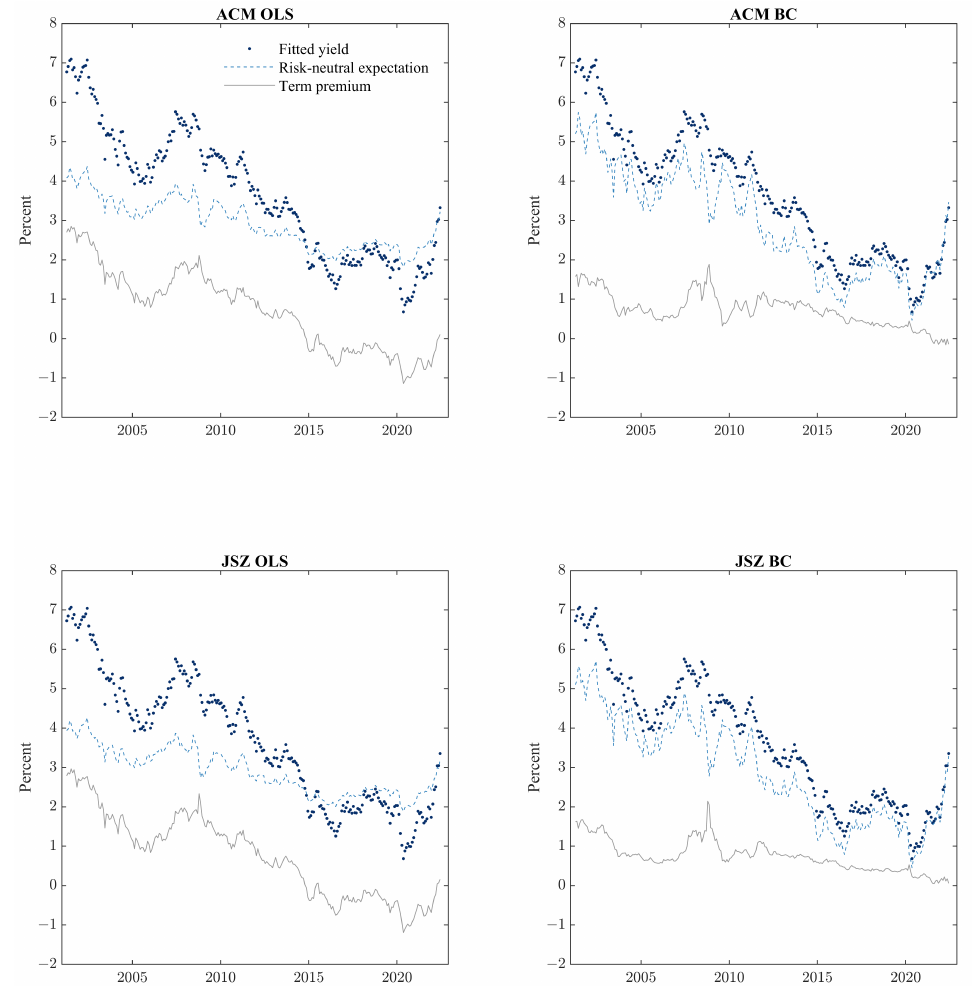
Figure 8. Impact of bias correction on 10 y term premia estimates. The effect of bias correction following Pope (1990) (BC—right panel) on the decomposition of yields into term premia and risk- neutral expectations, compared with OLS estimation (OLS—left panel). Sample period: 2001/04 to